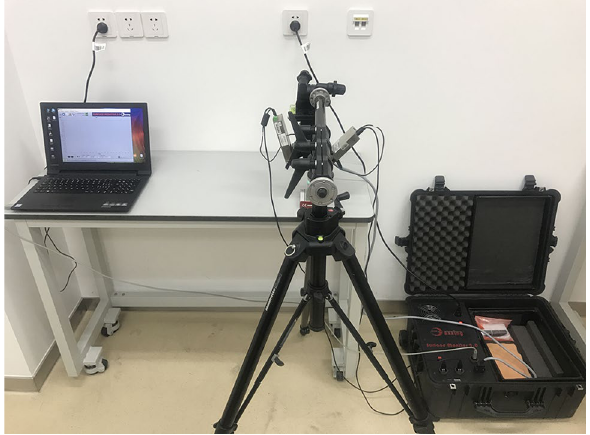
Fig. 1 Portable coupled XRF- XRD experiment scenes for the samples. a Raw mineral. b Polished gemstone. c Pigment powder. d Chinese ink stick. The left arm was the Newton Scientific Inc. Mini-X X-ray tube, the right arm was the Amptek X-123 SDD X-ray spectrom- eter, and the middle was the samples placed on glass slides. The polished gemstone was fixed at the plasticine to ensure the flat surface measured was parallel to the ground. The laser spot indicated the meas-